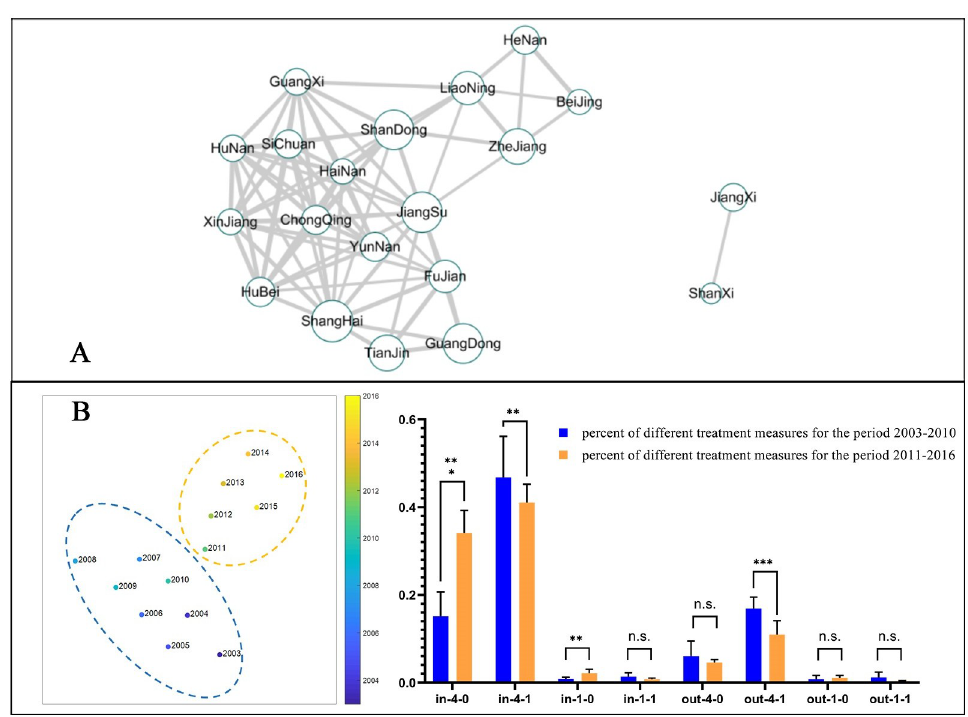
Fig 7. A network diagram of "survival status–quarantine status–treatment measures" and its statistical analysis by year. (A) A "survival status–quarantine status–treatment measures" network diagram for provincial ports. The size of the circle represents the number of interceptions, the thickness of the line represents the size of the correlation, and lines are only produced for correlations > 0.8. (B) A "survival status–quarantine status–treatment measures" clustering analysis by year. Quarantine status is denoted by 1 for quarantine pests and 4 for non-quarantine pests. Treatment measures are denoted by “out” for return, destruction, and sealing and “in” for inspection and quarantine supervision, fumigation, and pest control treatment. Survival status is denoted by 1 for living and 0 for dead. Together these three categories give rise to eight combinations. ��� P < 0.01, �� P < 0.05, n.s. P > 0.05, Student’s t -test.